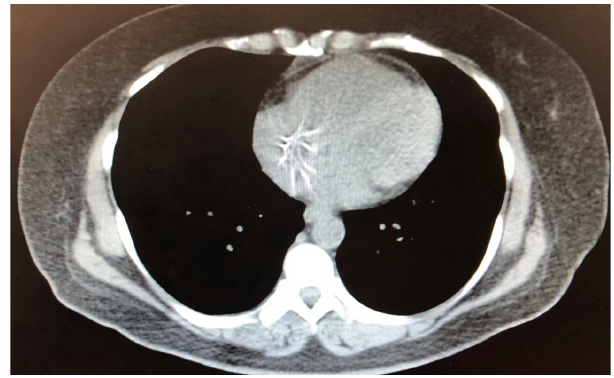
Video 1 - Inferior vena cava filter being removed after cardiopulmonary bypass start via right atriotomy.